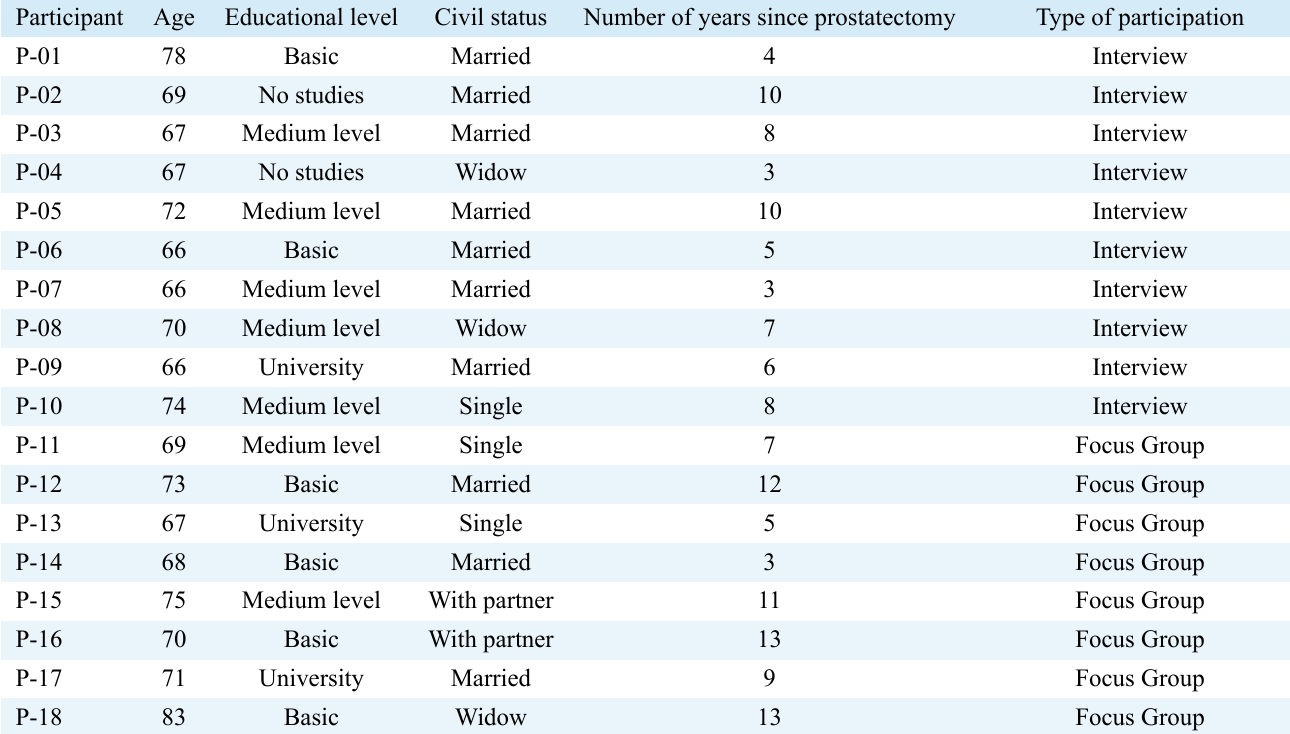
TABLE 1. Sociodemographic profile of the participants.